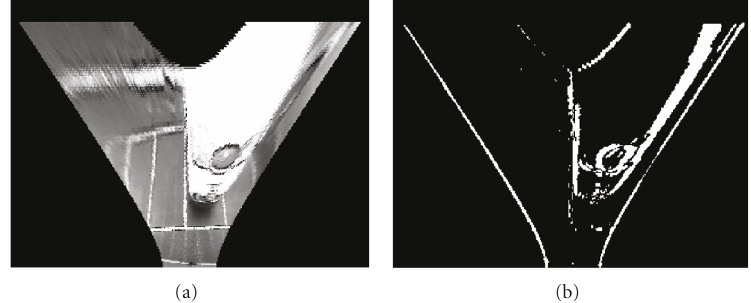
Figure 11: The results of the temporal FLIPM process, (a) the remapped image (b) the temporal di ff erence